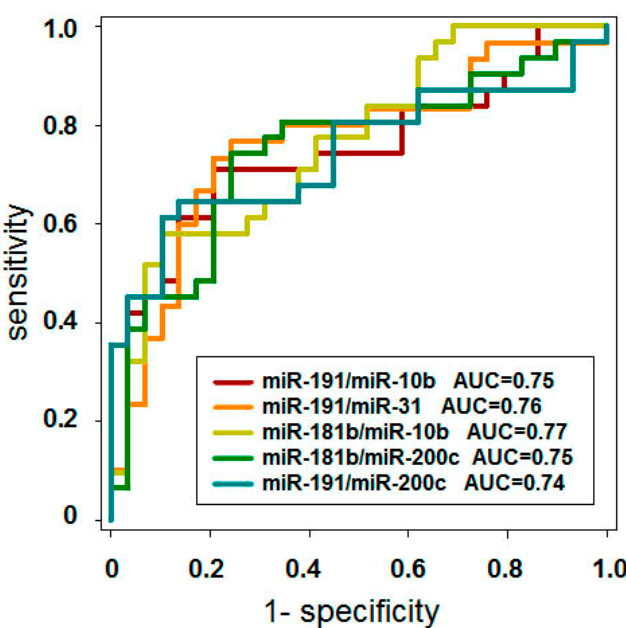
Figure 5. Receiver operation curve (ROC) analysis of the ratios of reciprocally dysregulated miRNA pairs. The concentration ratios of reciprocally dysregulated miRNAs pairs were calculated and the diagnostic potency of these parameters was estimated by ROC analysis with set of 63 samples (CNT, n = 33 and AM, n = 30). Areas under curve (AUC) values (A) are shown.